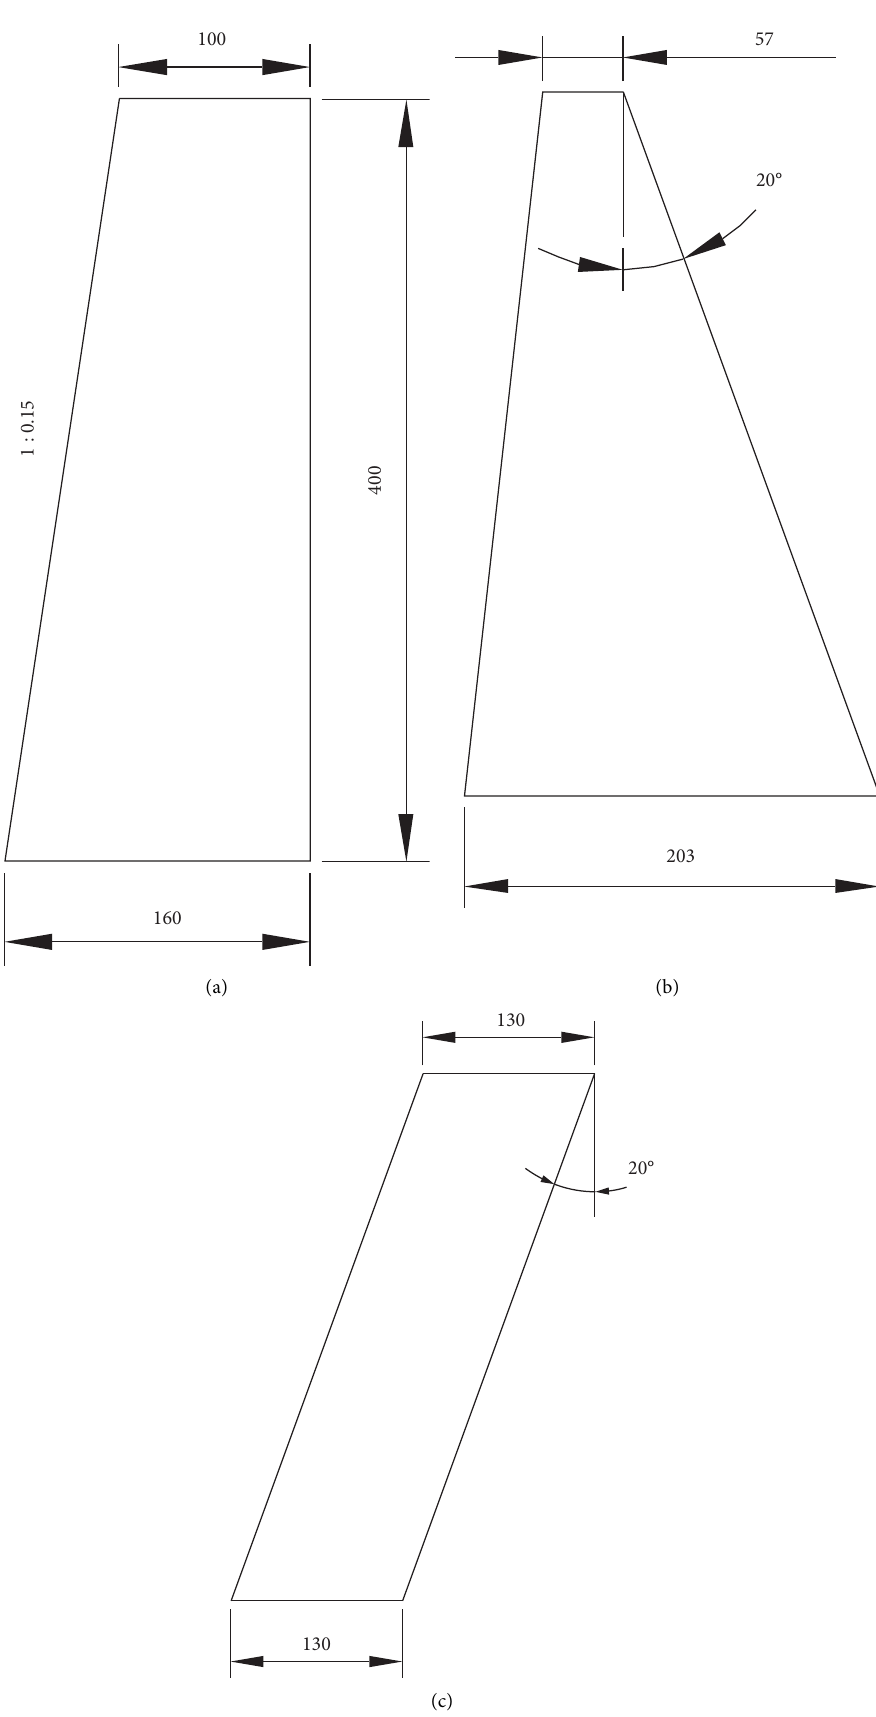
Figure 1: Wall model size of retaining walls (unit: mm). (a) Vertical walls. (b) Inclined walls. (c) Reclined